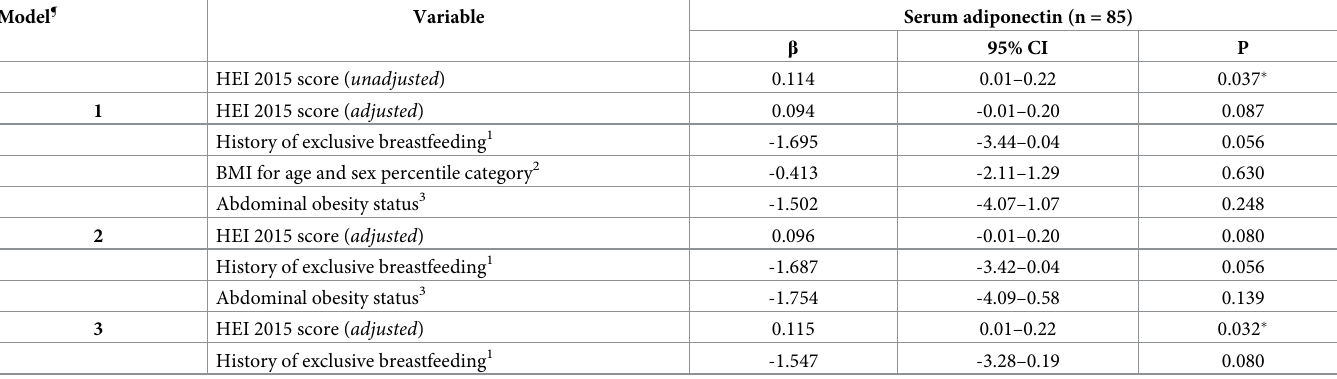
Table 3. Multiple linear regression analysis between Healthy Eating Index 2015 and serum adiponectin (n = 85).